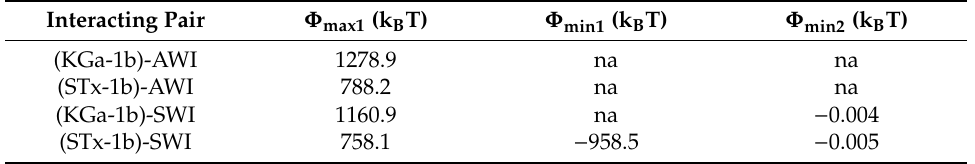
Table3. EstimatedDerjaguin-Landau-Verwey-Overbeek(DLVO)interactionenergyprofilecomponents. Interacting Pair